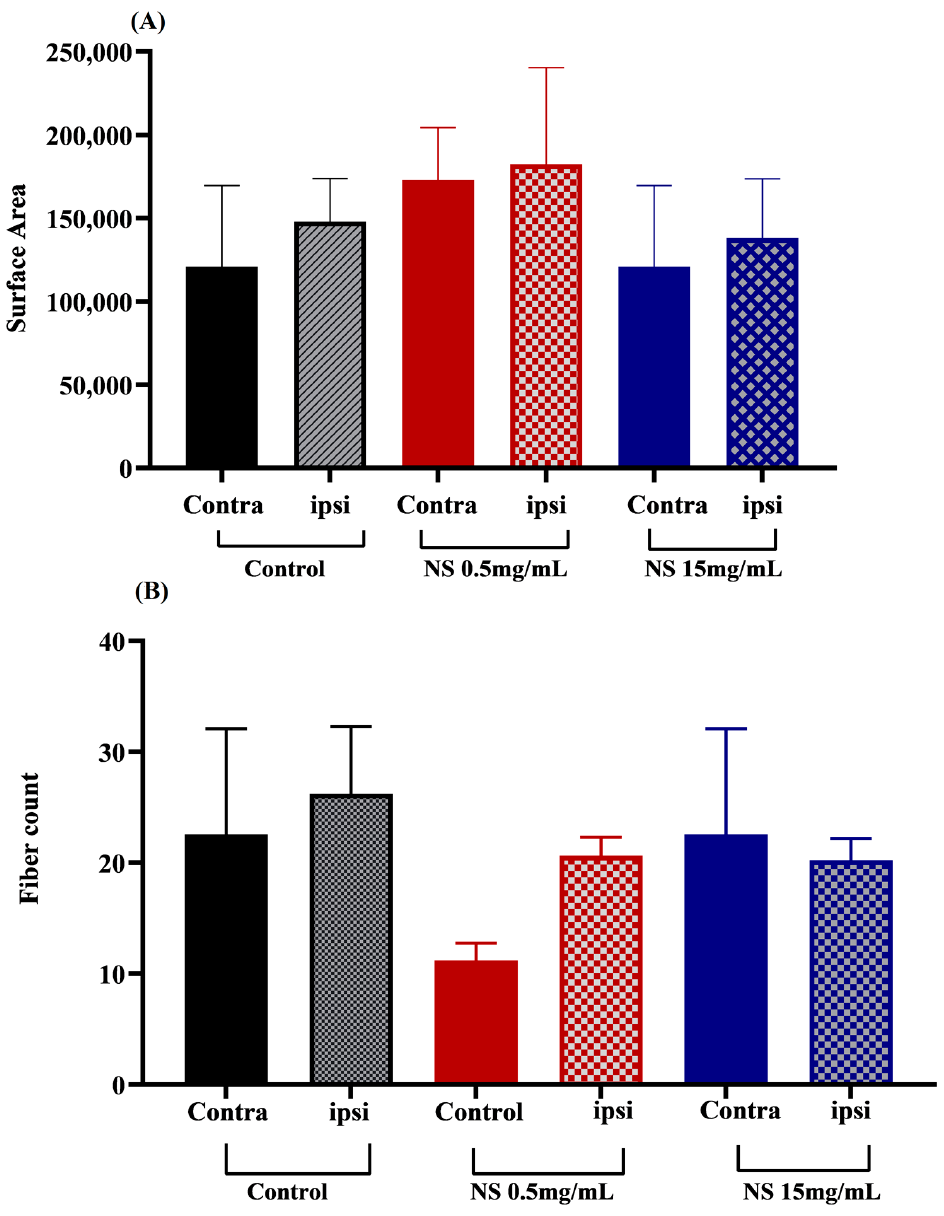
Figure 7. Effects of F. vulgare on ( A ) surface area and ( B ) fiber count contralateral v/s ipsilateral in tibialis muscles.